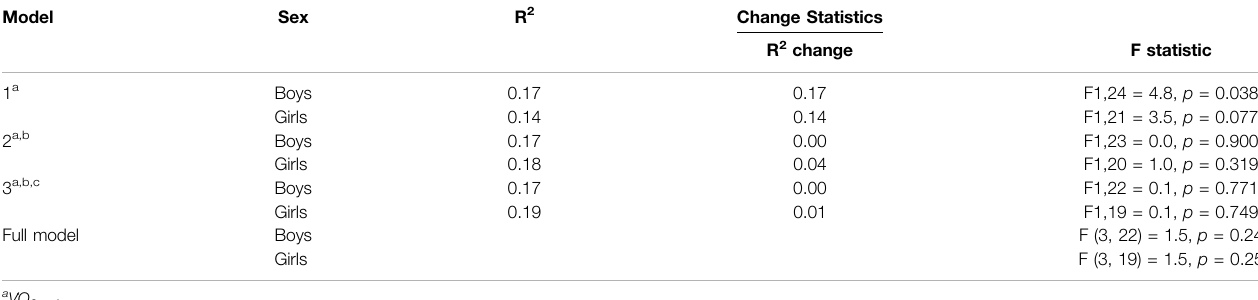
TABLE 3 | Full stepwise multiple regression analysis of V _ O 2peak (model 1), Σ O 2def (model 2), GE (model 3) for sprint performance. Model